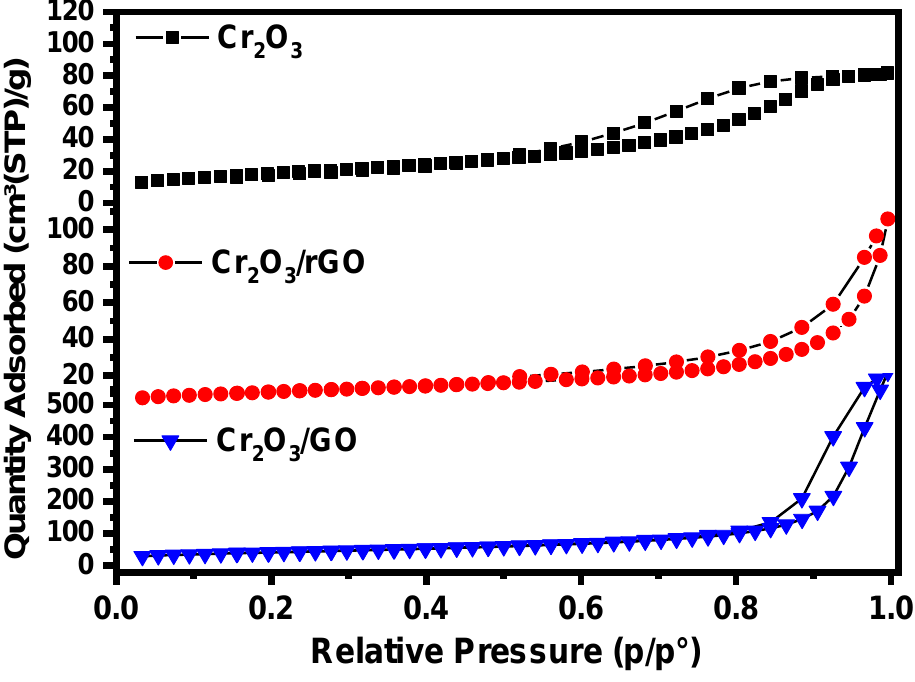
Figure 6. N 2 adsorption-desorption isotherms for Cr 2 O 3 NPs, and the hybrids Cr 2 O 3 / rGO and Cr 2 O 3 / GO.